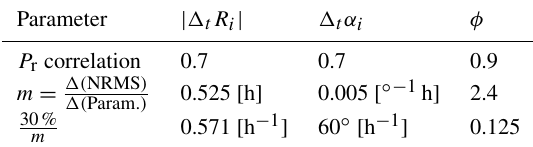
Table 2. Summary of correlations between NRMS error in TR esti- mates and the three forecast parameters for storage-release events, in terms of the Pearson correlation coefficient ( P r ), and fit line (least squares) slopes ( m ) in Figs. 8, 10 and 12. The last row indicates the amount of change in forecast parameters that would result in > = 30% error in estimates. φ < 10% corresponds to < 30%